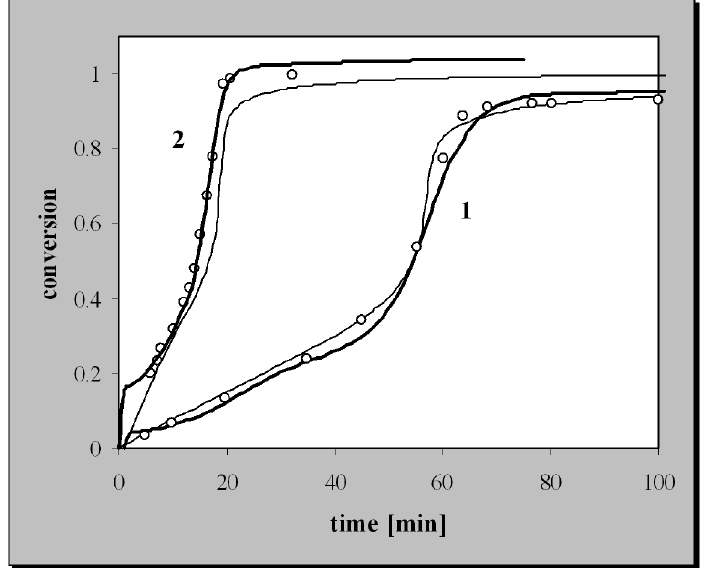
Fig. 8 Comparison between conversions obtained with mechanistic model (thin lines), neural network model (thick lines) and experimentally (o) at (1) T = 70 o C and I 0 = 25.8 mol/m 3 and (2) T = 90 o C and I 0 = 25.8 mol/m 3